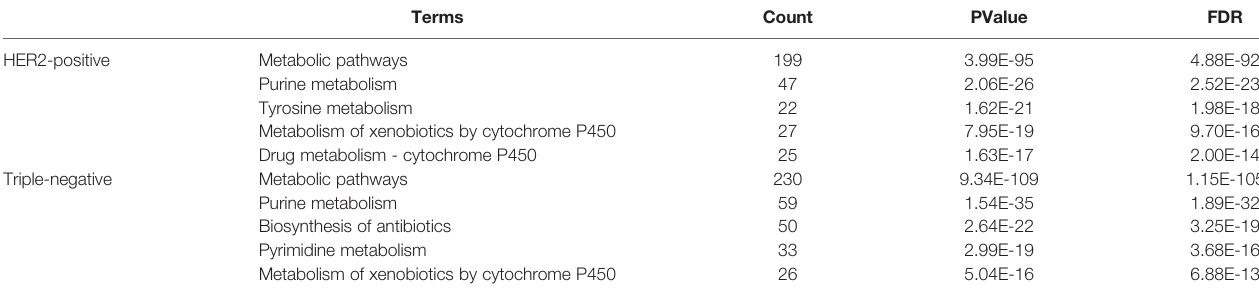
TABLE 1 | KEGG pathway analysis about the differential metabolism-related genes in HER2-positive and triple-negative breast